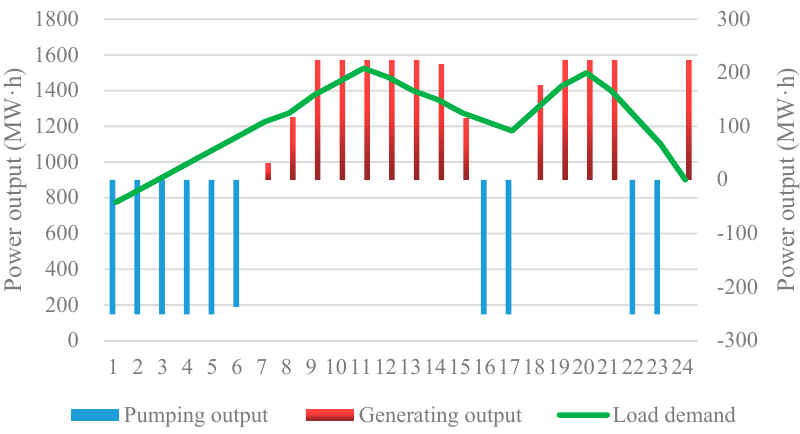
Figure 8. The real-time output of the pumped storage unit in the basic dispatching system.